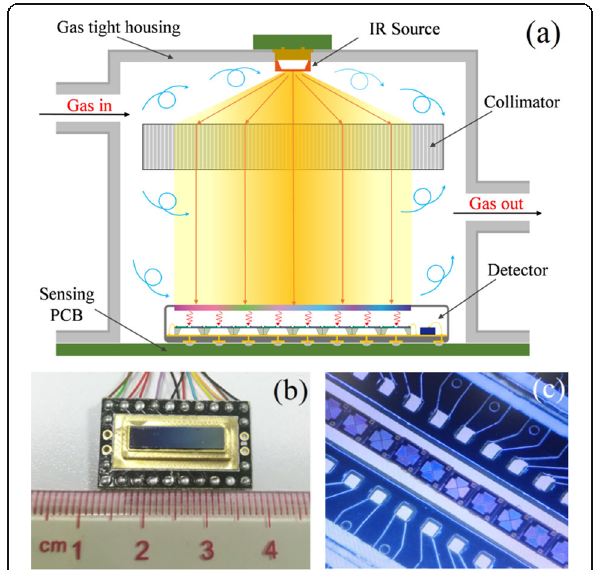
Fig. 7 a Schematic diagram of working principle of miniaturized mixed gas detector. b Photographs of the miniaturized LVOF-based spectrometer. c The thermopile chip array packaged in socket